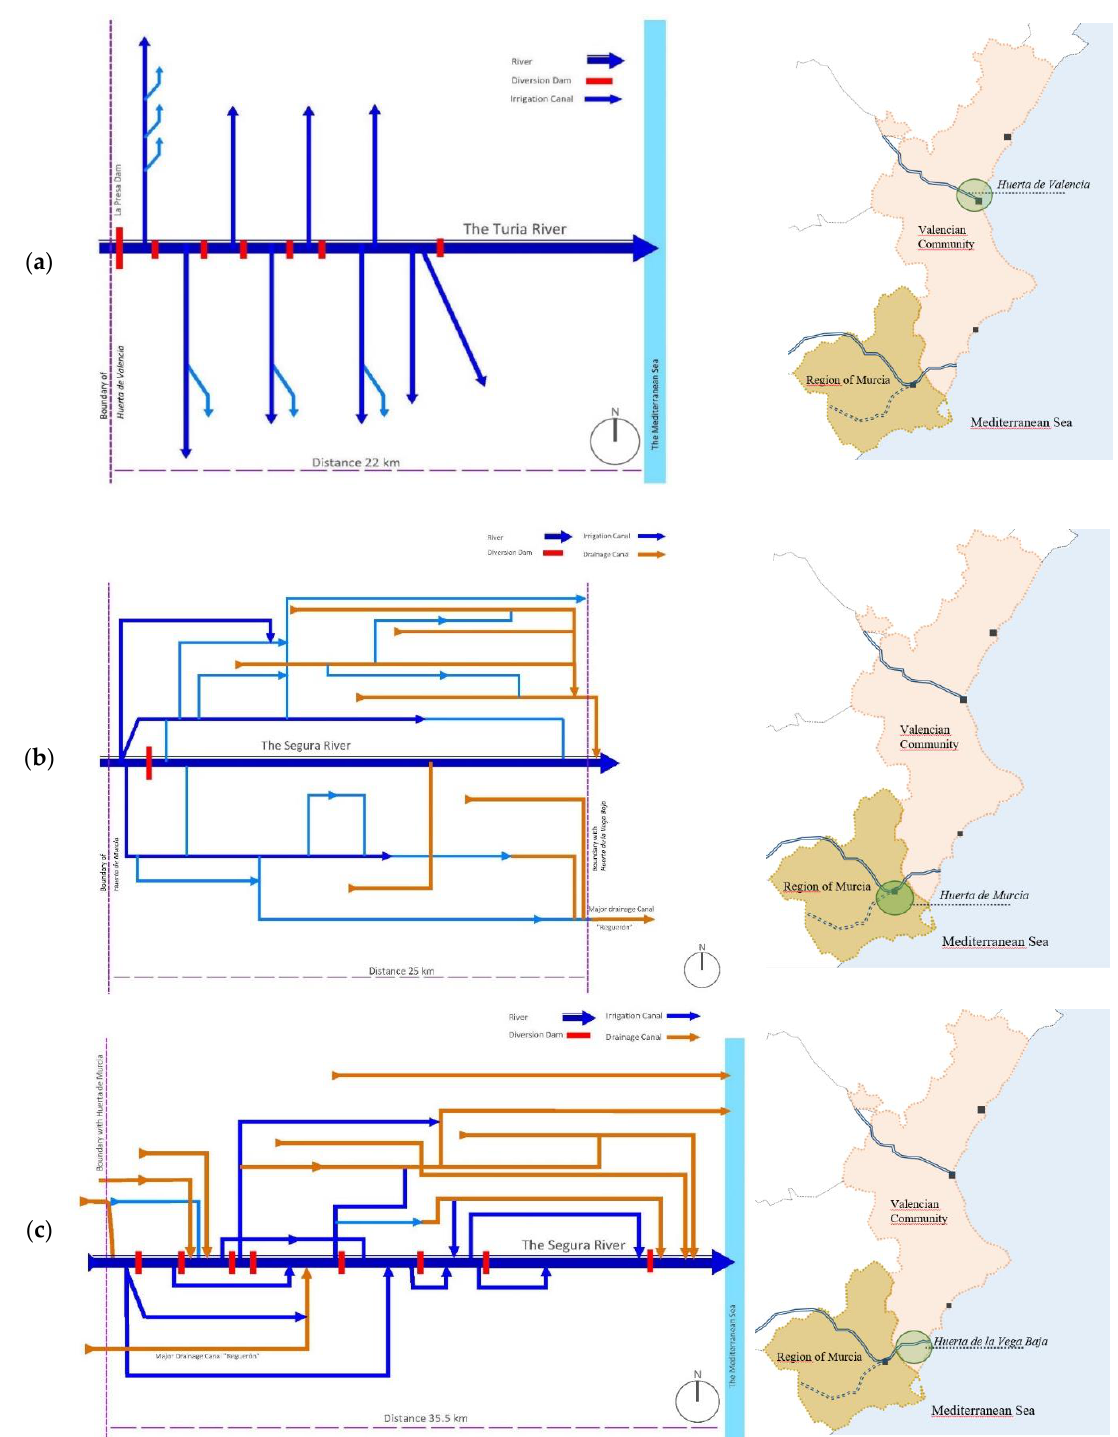
Figure 4. Schematic diagrams of the water distribution circuitry in each of the Huerta territories. ( a ) Huerta de Valencia in the final stretch of the Turia River. Diagram based on PAT Huerta de Valencia documents [28]. ( b ) Huerta de Murcia , at the Segura River’s middle course, between the Contraparada Dam and the boundary with the province of Alicante. Diagram based on Segura Water Authority documents [49]. ( c ) Huerta de la Vega Baja , from the Murcia boundary to the river mouth at the Mediterranean Sea. Diagram based on Segura Water Authority documents [50]. Red markers represent the diversion dams along the river courses. Diagrams not to scale.